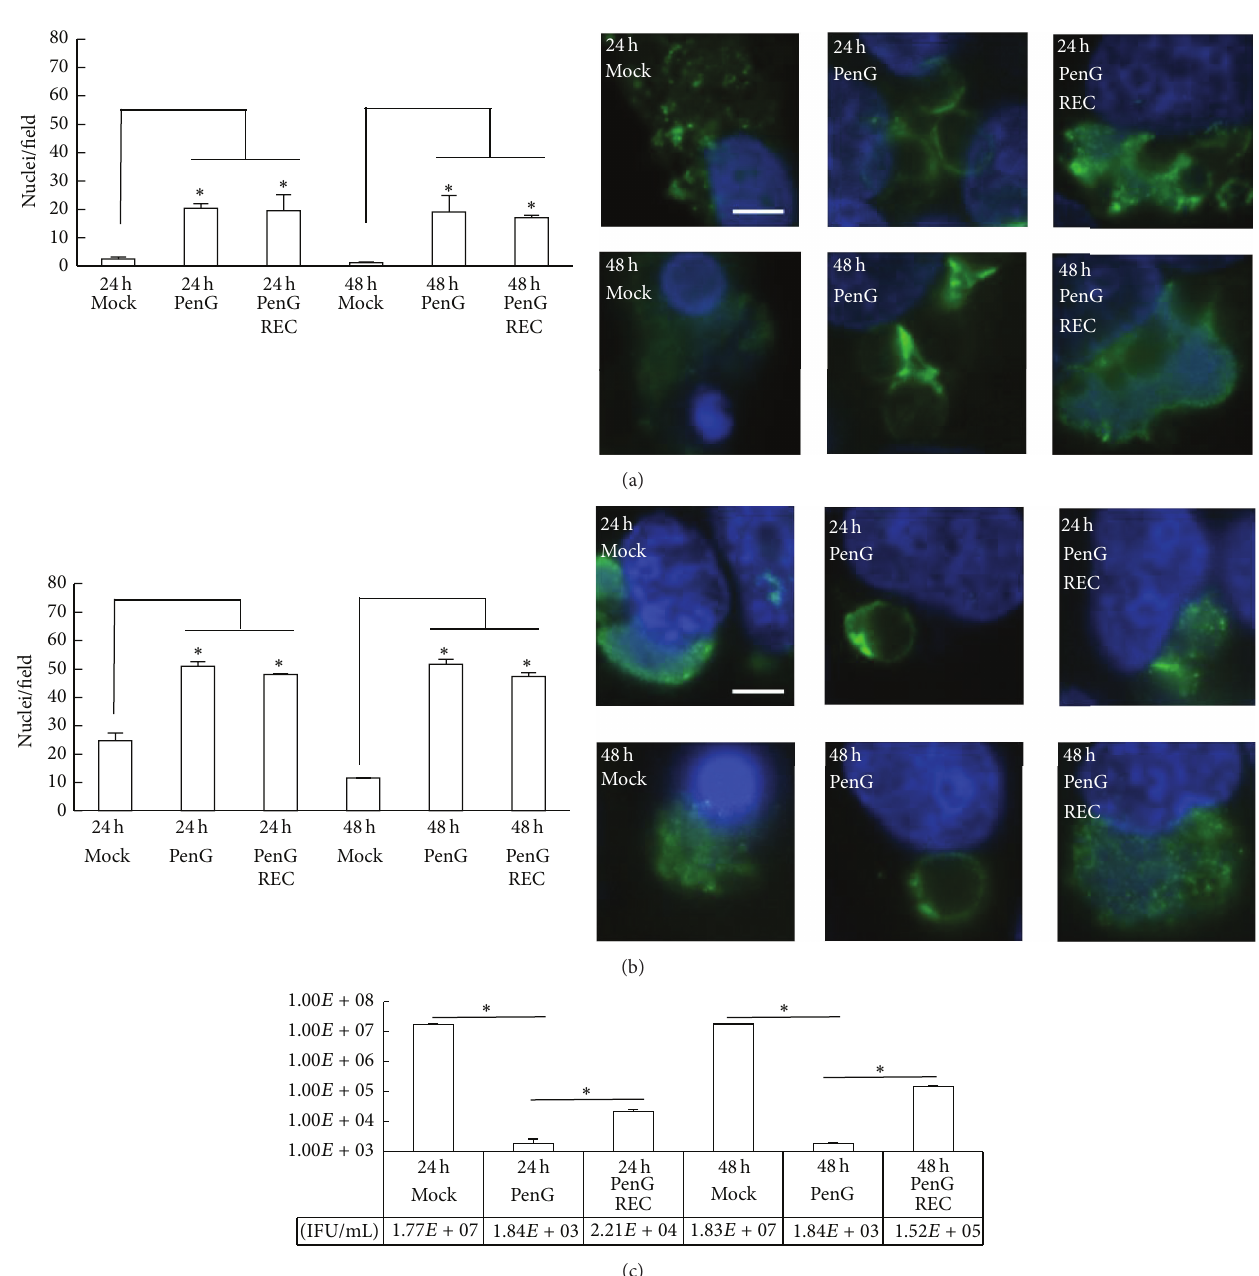
Figure 3: Penicillin G exposure prevents Chlamydia pecorum -mediated cell death and C. pecorum recovers infectivity upon discontinuation of penicillin exposure. C. pecorum -infected HeLa cells were penicillin G (PenG) exposed or diluent exposed (mock) from 0 to 35 hours postinfection (hpi). Cycloheximide was included (a) or not included (b, c) in the incubation medium. At 35 hpi, medium was changed to continue or discontinue (recovery, REC) penicillin exposure for 24 or 48 hours (h) and cycloheximide was maintained for (a). Inclusions were visualized and mean nuclei per field were determined as described for Figure 2. Representative immunofluorescence microscopic images illustrate cell death in mock-exposed controls, inclusions containing aberrant bodies upon continued penicillin exposure and normal- appearing inclusions upon recovery (REC). Production of infectious elementary bodies was determined by titration by subpassage and expressed as inclusion-forming units (IFU)/mL. Results are means ± standard deviation. The two-tailed t -test was used to compare means; p ≤ 0.05 = significant ( ∗ ) ; 𝑛 = 2 . Scale bars = 5 𝜇